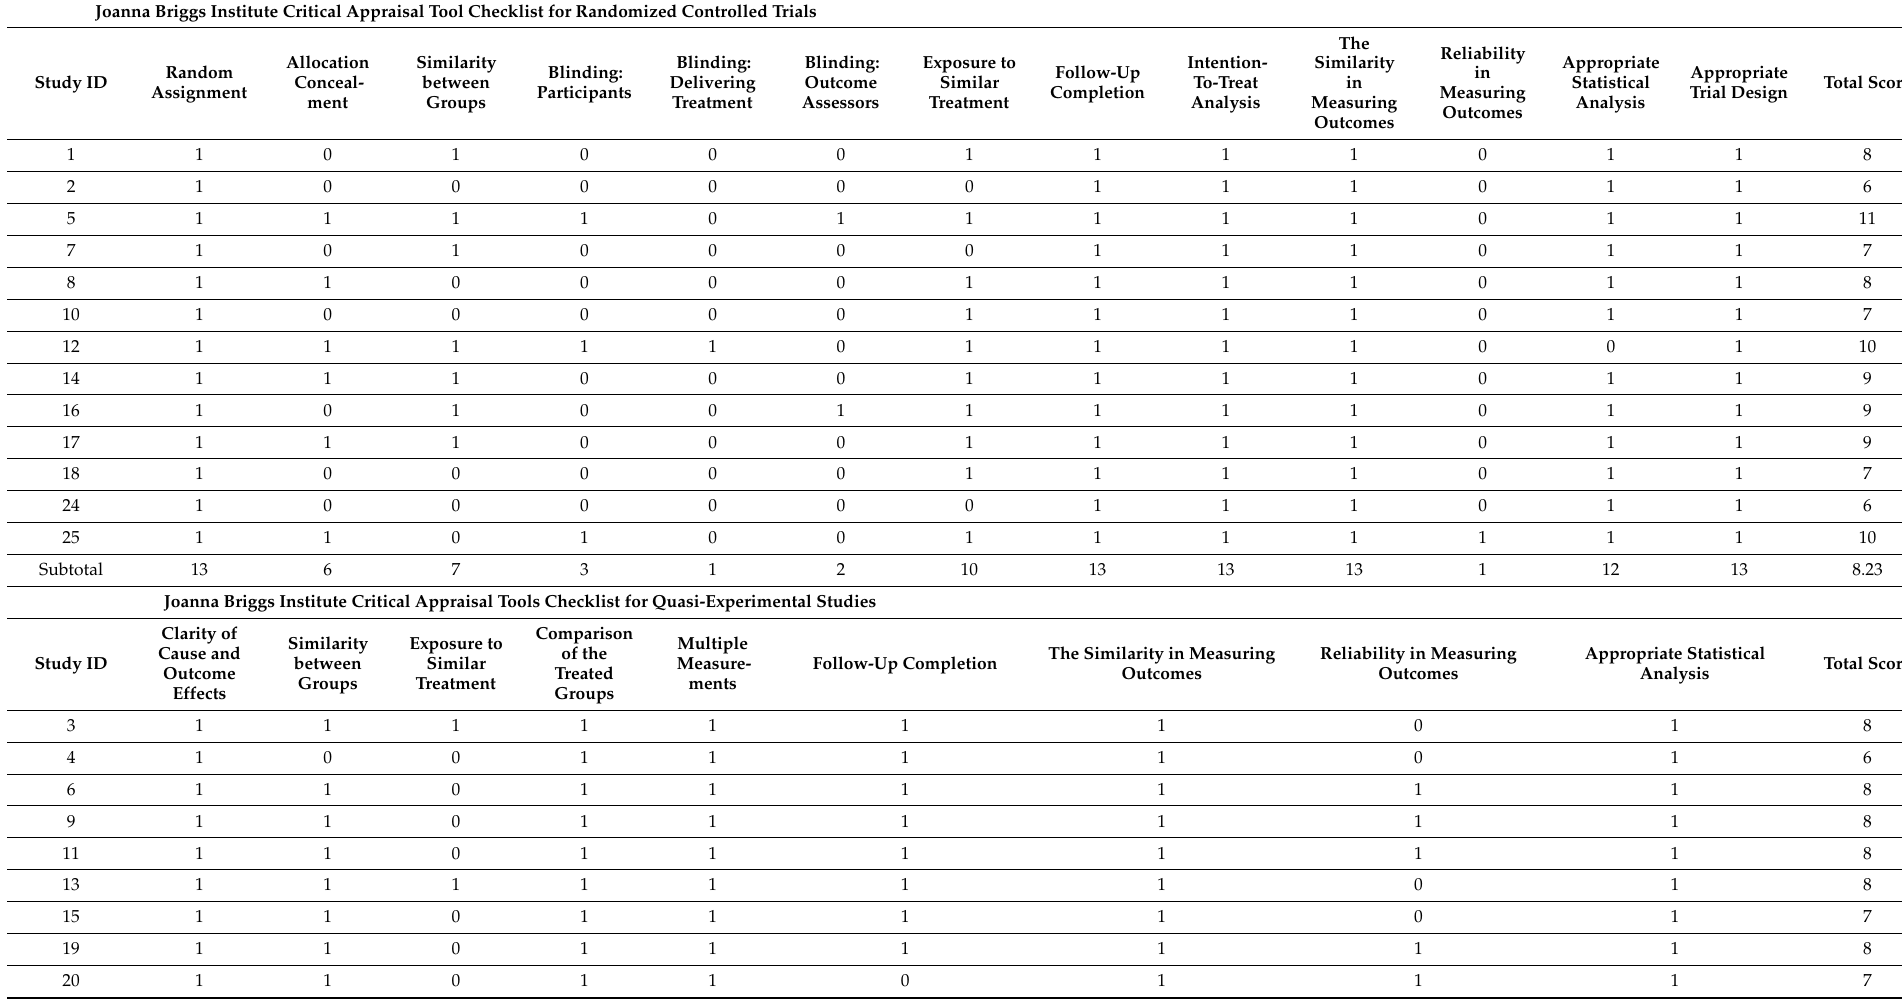
Table 3. Quality assessment of the included